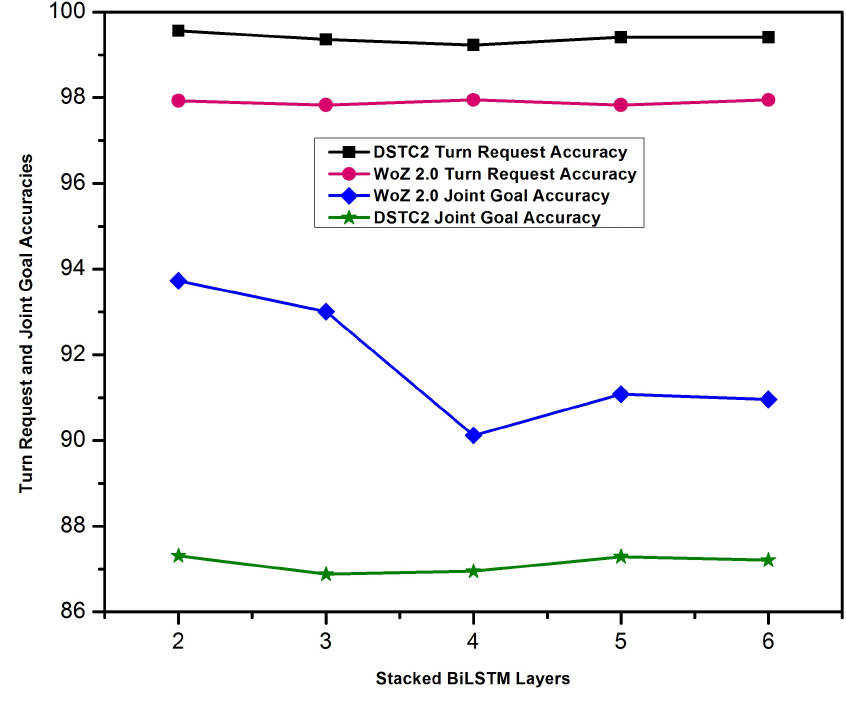
Figure 6. Impact of Stacked